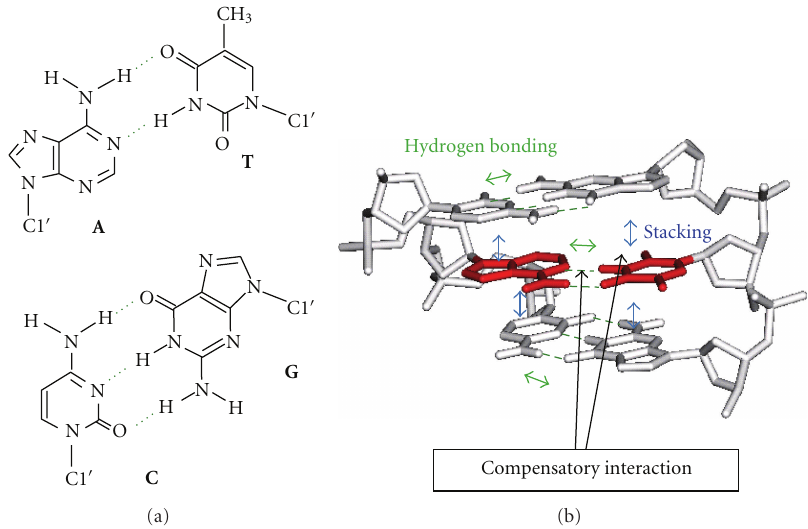
Figure 1: (a) Watson-Crick A/T and C/G base pairs. C1 (cid:2) represents the 1 (cid:2) carbon atom of deoxyribose in DNA. (b) Interbase hydrogen bonding and stacking interactions formed in a DNA duplex. A compensatory relationship is suggested between the interaction energies of the hydrogen bonding and the base